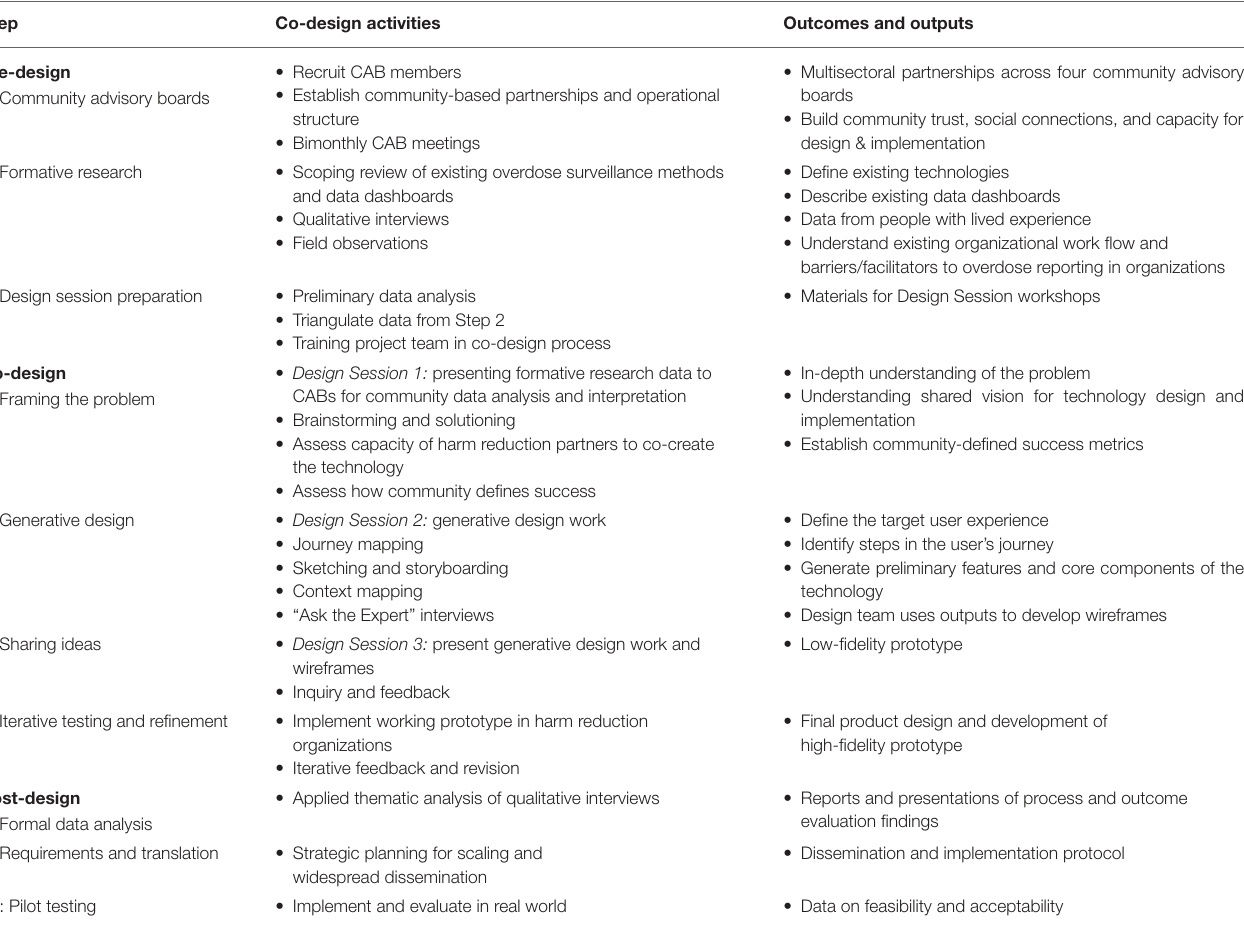
TABLE 1 | Summary of co-design activities and outputs.